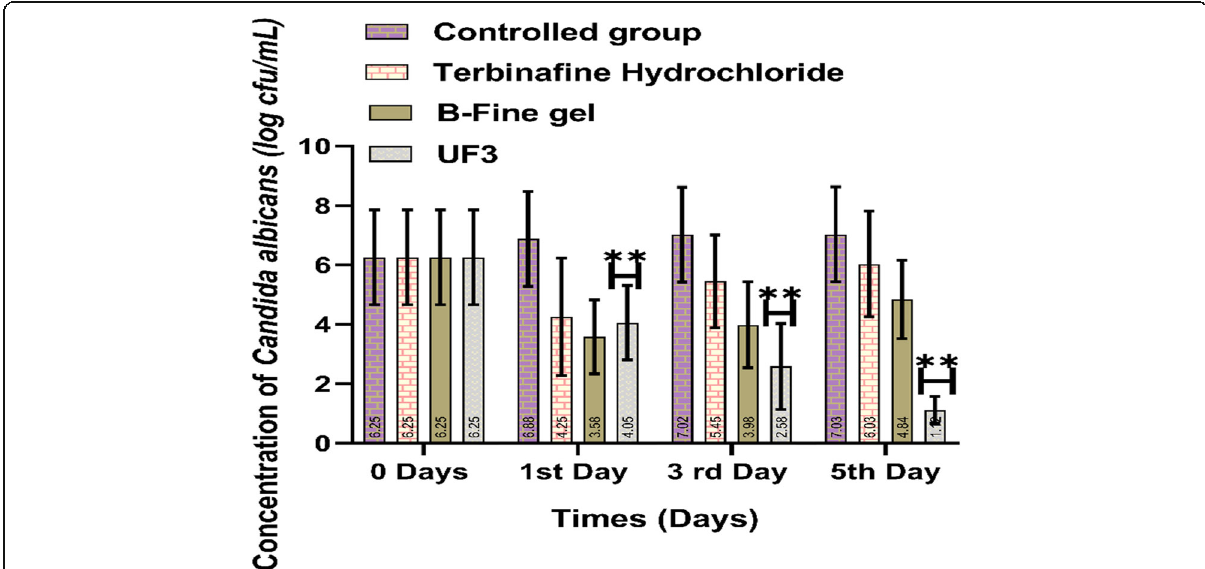
Fig. 8 In vitro antifungal activity of terbinafine hydrochloride, B-Fine gel, and UF3. Values expressed as mean ± SD ( n = 3), where ** p < 0.05 UF3 formulation versus other